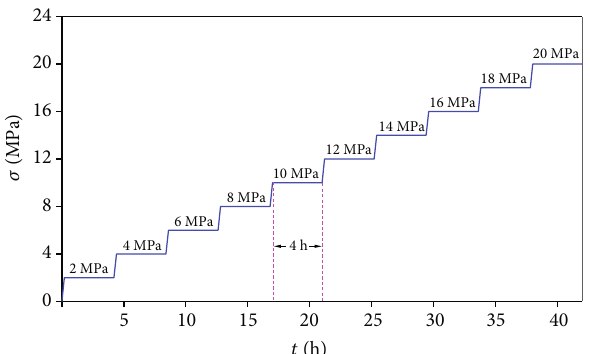
Figure 4: Stress loading schematic diagram of the creep test scheme under fractional